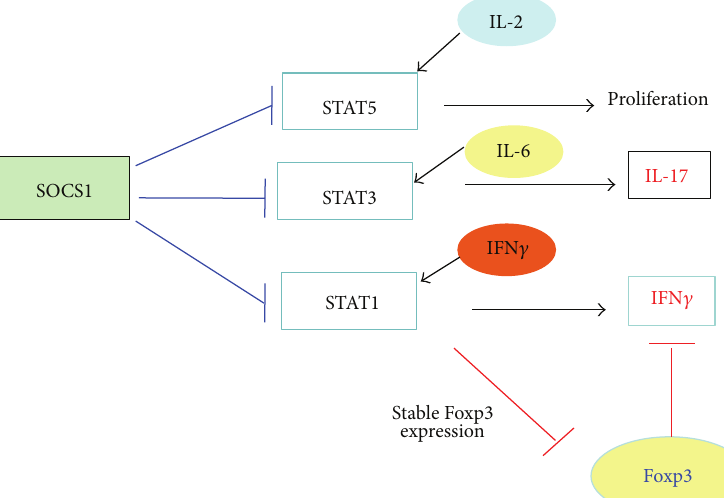
Figure 3: Role of STAT1 and STAT3 in Foxp3 expression and cytokine production in Tregs. SOCS1 protects Tregs from harmful effects of inflammatorycytokines,whichpromotethelossofFoxp3expressionandtheconversionintoTh1-andTh17-likeeffectorcells.Hyperactivation of IFN- 𝛾 -STAT1 pathway results in the loss of Foxp3 expression and hyperproduction of IFN- 𝛾 . Although STAT3 is not directly involved in Foxp3 expression maintenance, it may be crucial for suppression of the production of IL-17. SOCS1-deficient Tregs may expand faster due to hyperactivation of